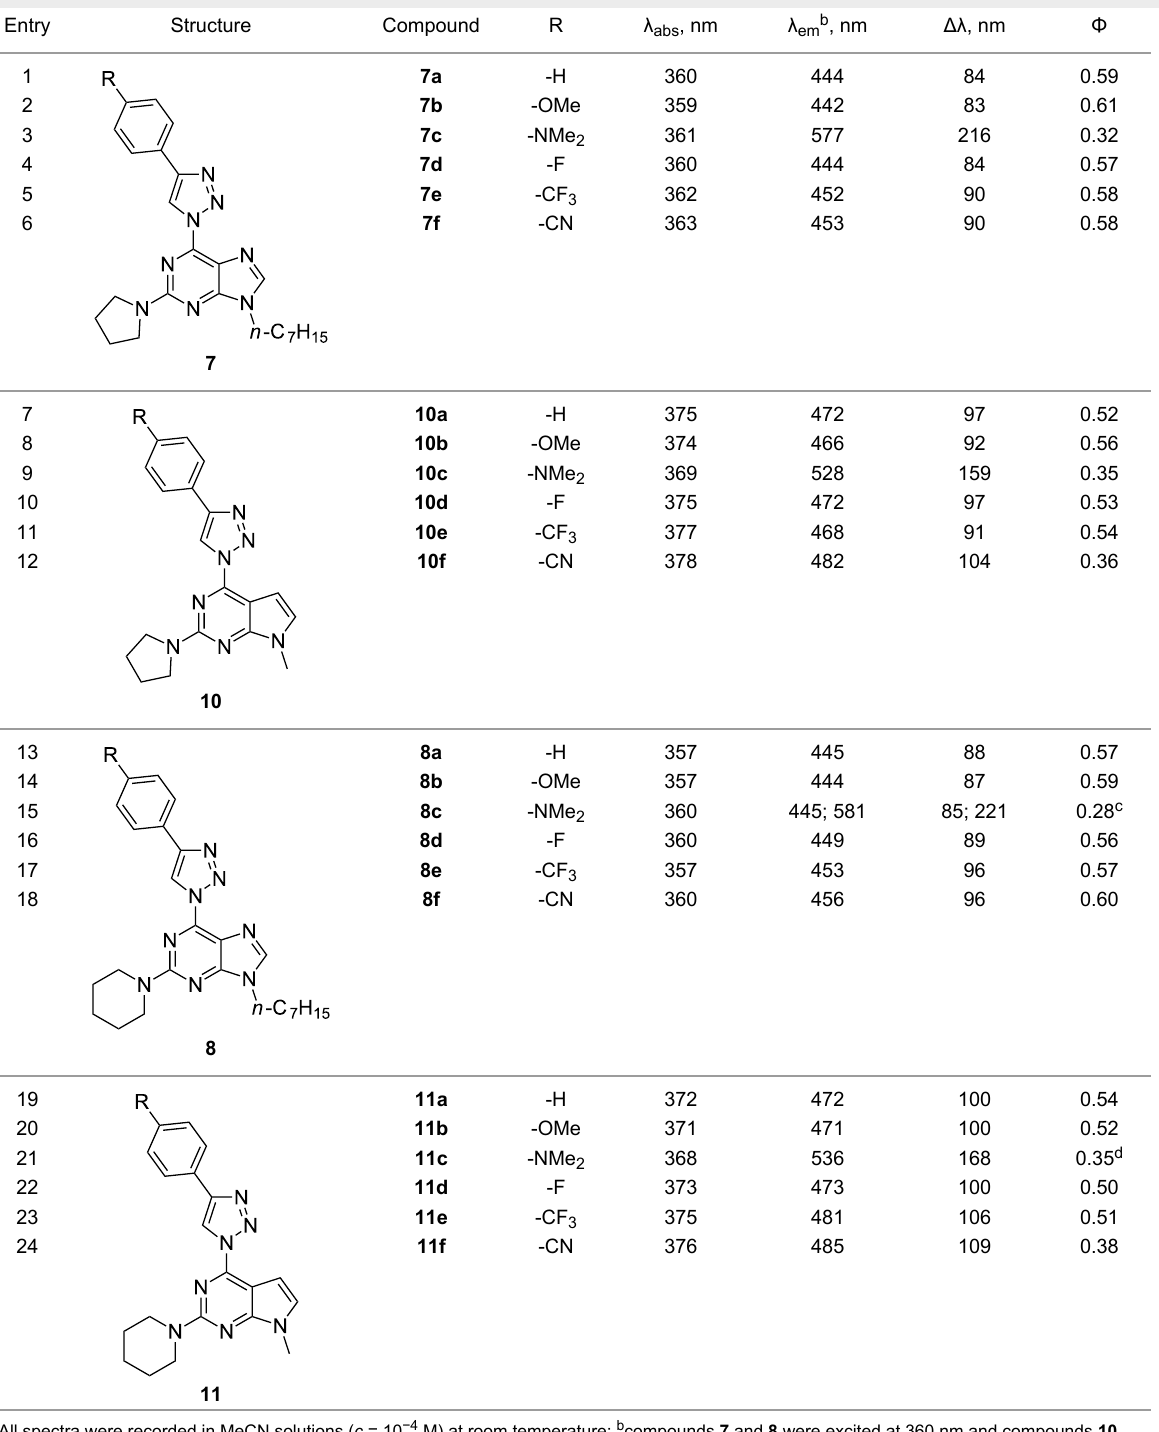
Table 3: Photophysical properties of 6-triazolyl compounds 7a–f , 10a–f , 8a–f and 11a–f .